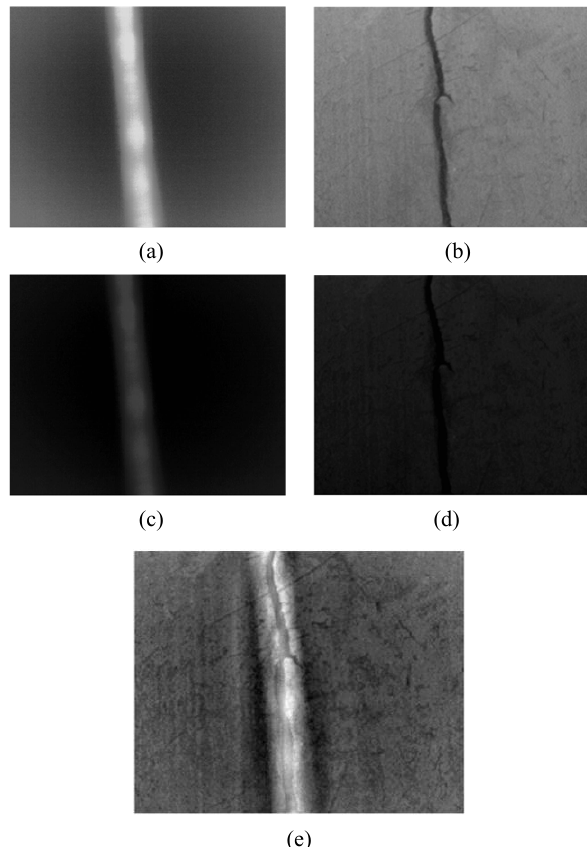
Fig. 7 Input images and simulation results: (a) infrared image, (b) visible light image, (c) infrared image with the effect, (d) visible light image with the effect, and (e) fusion image. Table 2 Performances of simulation